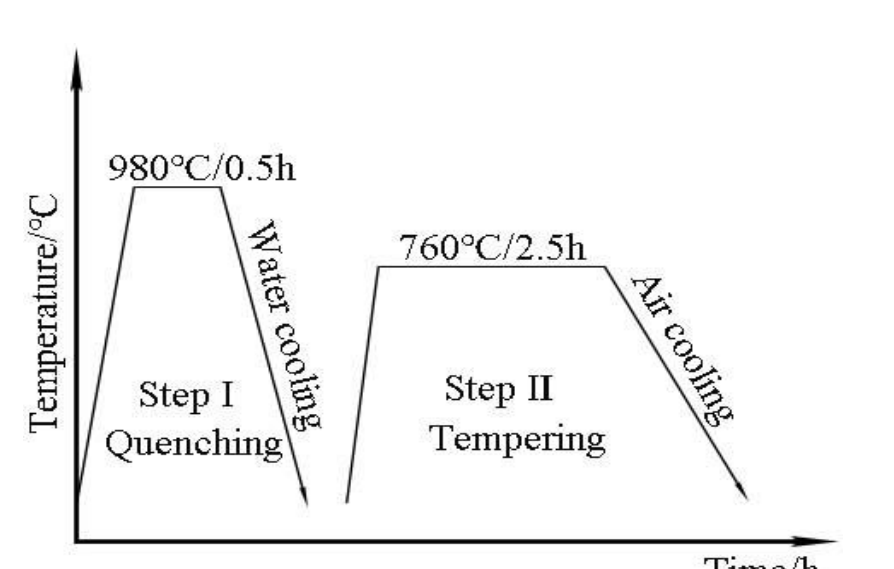
Figure 5. Heat treatment process.